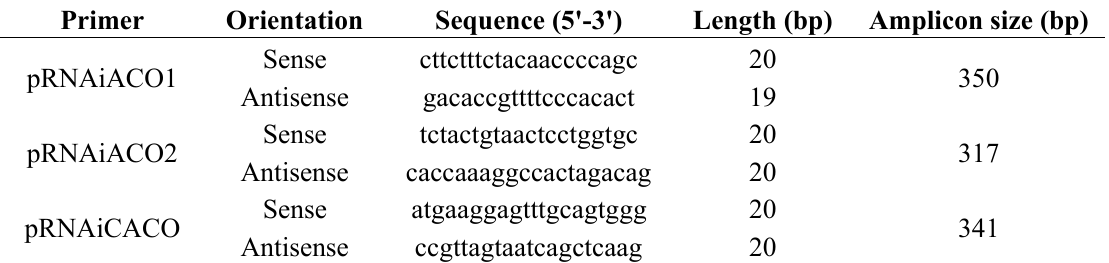
Table 2. Sequence of the primers used for developing RNAi